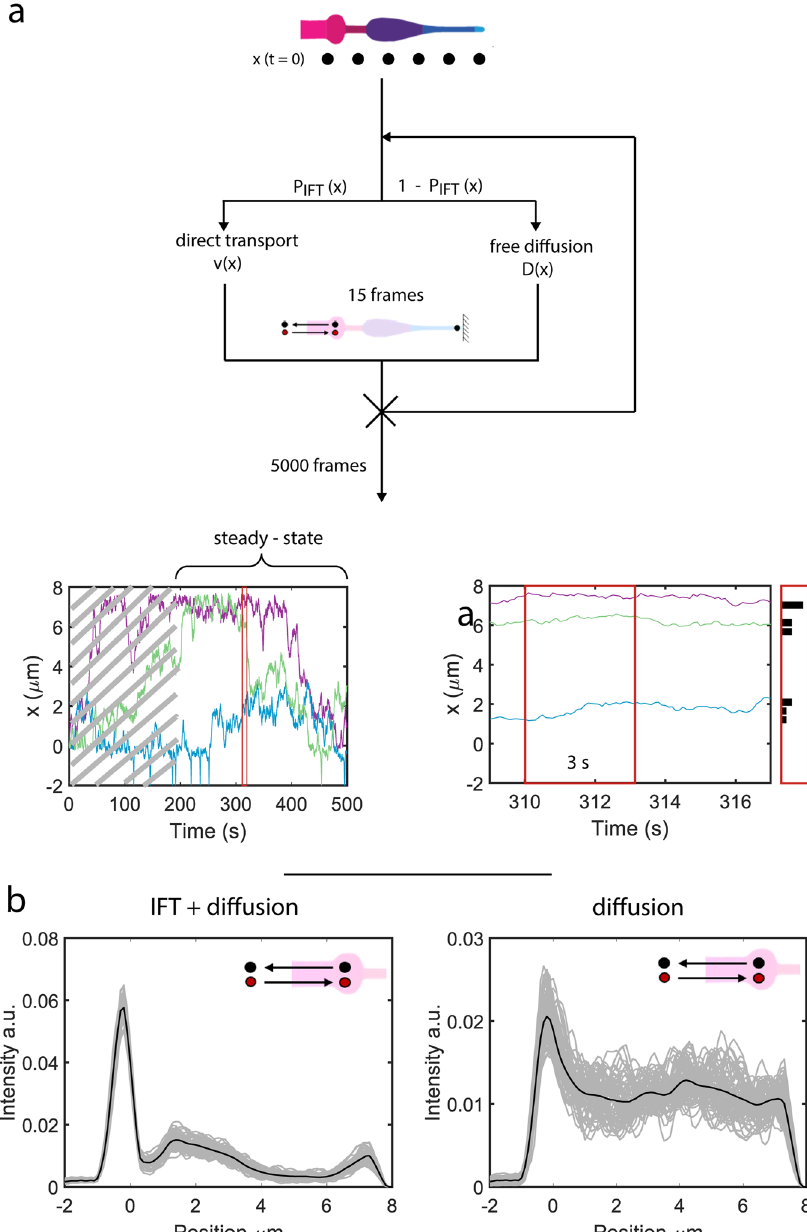
Fig. 5 Computer simulations of OCR-2 intensity pro fi les. a Cartoon depicting the simulations (see “ Methods ” section) and resulting trajectories (bottom). After reaching steady state (after ~180 s in trajectory bottom left) the positions of the molecules are collected within a time window of 3 s (zoom of trajectory including position histogram, bottom right). b Simulated OCR-2 intensity pro fi les with the velocities and diffusion coef fi cients extracted from the analysis of the single-molecule trajectories as input parameters (Fig. 4d and Supplementary Table 1). Left: IFT/diffusion ratios used correspond to the values in Supplementary Table 1. Right: the IFT/diffusion ratio is set to 0, in order to mimic OCR-2 in the bbs-8 mutant background. The number of OCR-2 is constant and each OCR-2 leaving the cilium towards the dendrite is replaced by one entering. Gray lines represent the averaged distributions of OCR-2 over a time laps of 3 s (similar to the experimental data in Fig. 1a), after reaching steady state. Black lines represent the distribution averaged over the complete steady-state regime (between 180 and 390 s (see also trajectories in a ; i.e., all gray curves averaged). Cartoon insets indicate that in the simulations the number of OCR-2 was forced to be constant (in